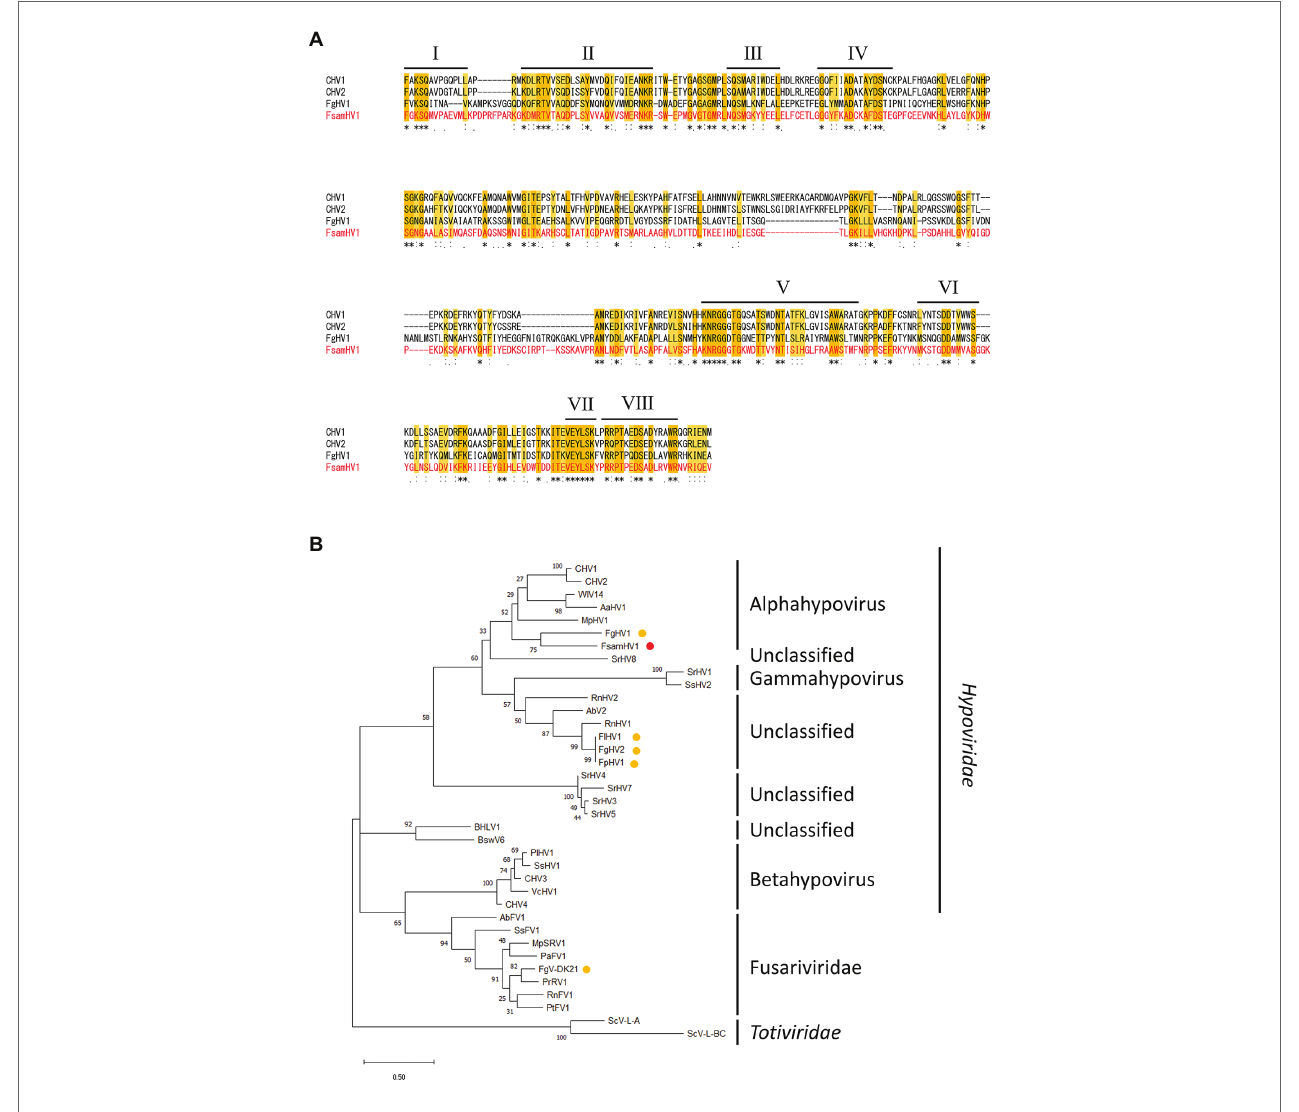
FIGURE 5 | Multiple alignment and phylogenetic placement based on the replicase sequence of FsamHV1. (A) Amino acid sequence alignment of the region corresponding to the RdRp domain. The position of eight core RdRp motifs and conserved residues (Koonin et al., 1991) are highlighted. (B) Maximum-likelihood (ML) phylogenetic tree based on the multiple alignment of amino acid sequences of conserved RdRp domain predicted on the putative replicases of FsamHV1 and on other definitive and tentative members of the families Hypoiviridae and Fusariviridae. Two members of the Totiviridae family were used as the outgroup. A red dot indicates FsamHV1, and yellow dots indicate hypoviruses and fusariviruses found in the Fusarium species. Bootstrap values obtained with 100 replicates are indicated on branches. Branch length corresponds to the genetic distance; the scale bar at the lower left corresponds to a genetic distance of 0.50. A list of full virus names and accession numbers used in this analysis is summarized in Supplementary Table S2